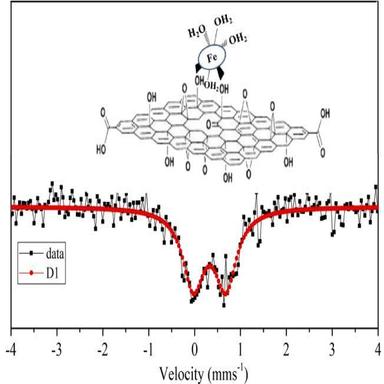
57Fe Mossbauer ¨ Spectrum of Fe-GO Nanocomposite at Room Temperature, with the inset displaying the anticipated compound structure based on Mossbauer ¨ study results.